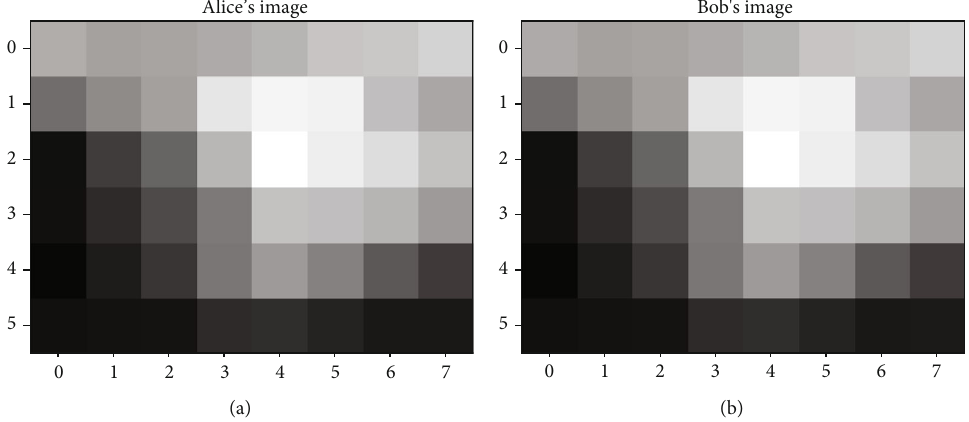
Figure 4: (a) Alice ’ s (same as Charlie ’ s) and (b) Bob ’ s images, with their votes embedded in the upper-left and lower-right pixels ’